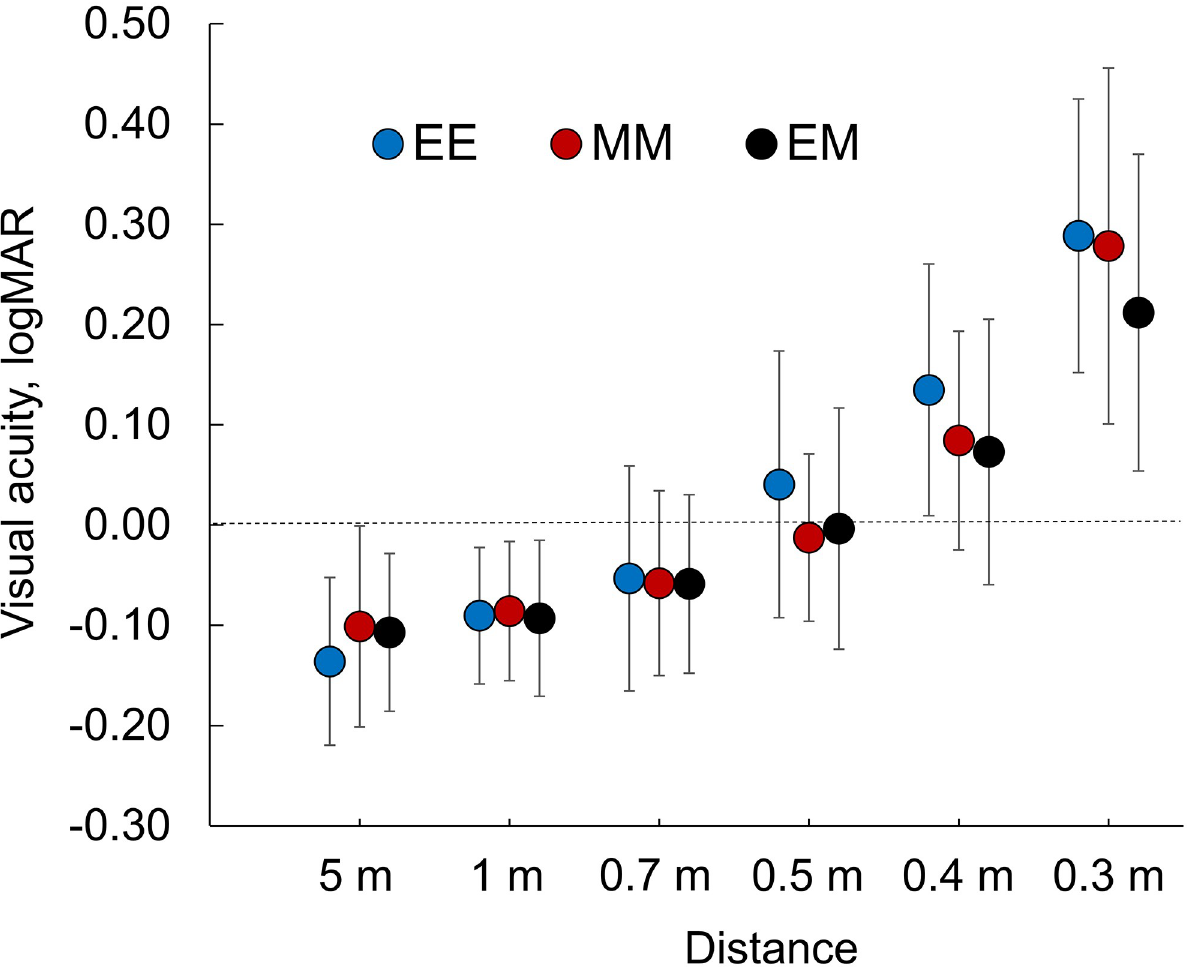
Fig 3. Binocular uncorrected visual acuities from 0.3 to 5.0 meter in three groups. Group EE: bilateral emmetropia, group MM: bilateral -0.5 diopters, and Group EM: monovision of emmetropia and -0.5 D. No significant differences are seen among the groups. logMAR = logarithm of the minimum angle of